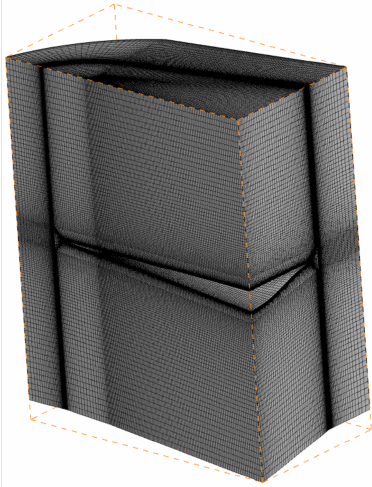
Figure 5. The grid of the